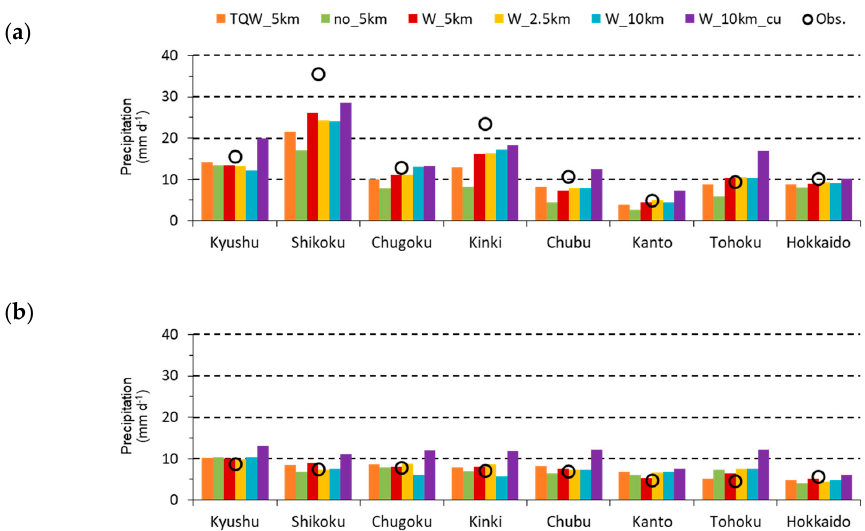
Figure 3. Mean daily precipitations averaged for the meteorological observatories in each region during ( a ) 1 to 15 and ( b ) 16 to 31 August 2014 for the observation and six WRF settings.